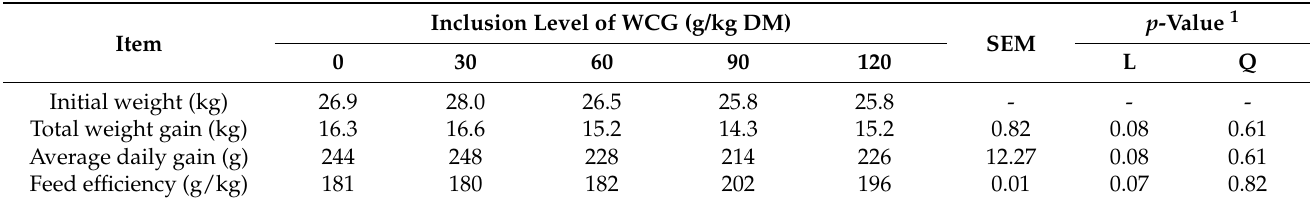
Table 6. Performance of lambs fed diets containing whole corn